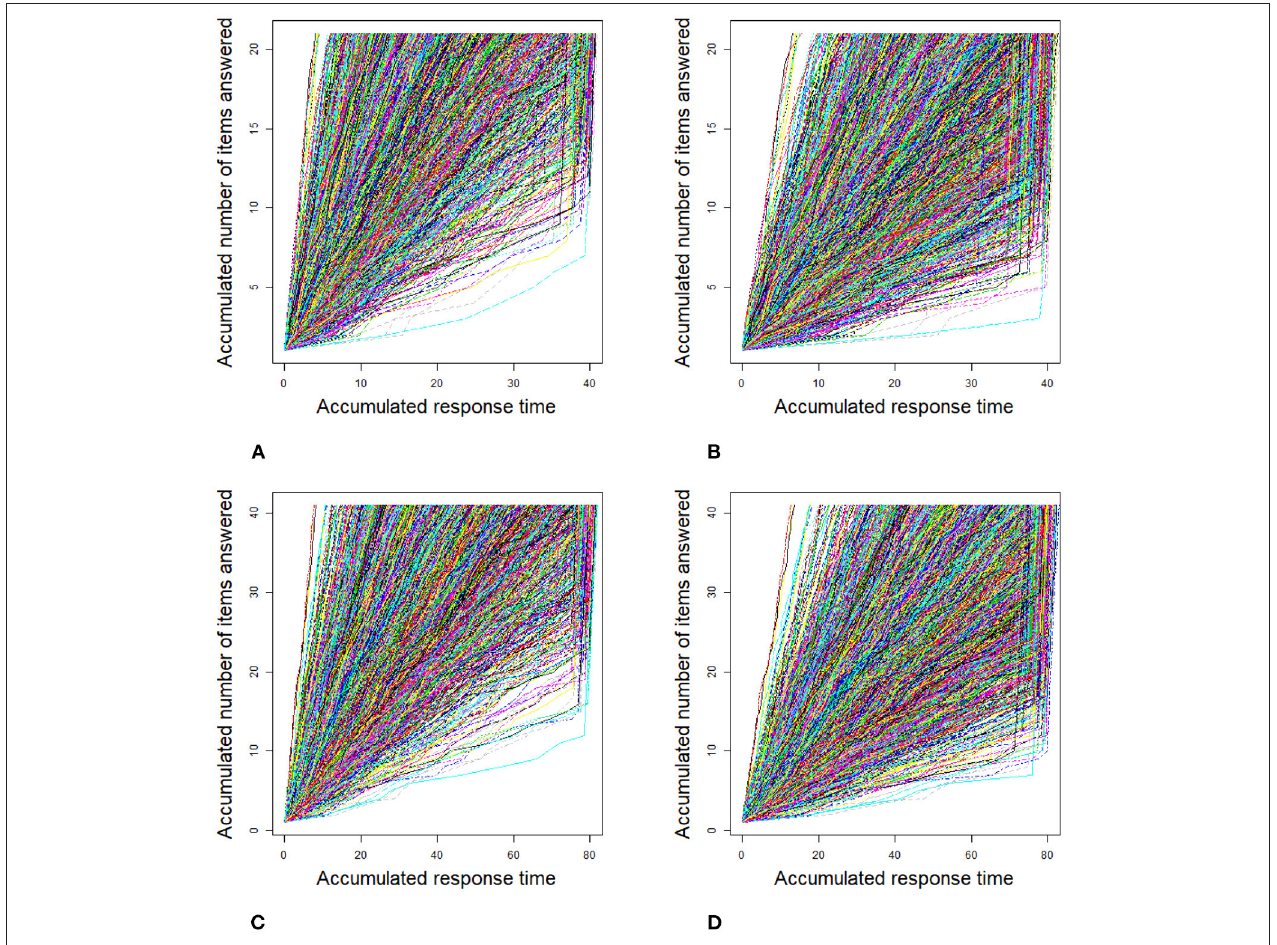
FIGURE 2 | Response time paths for 2,000 examinees at different speededness levels in the simulation study 1. (A) items 20 and low speededness, (B) items 20 and high speededness, (C) items 40 and low speededness, and (D) items 40 and high speededness.